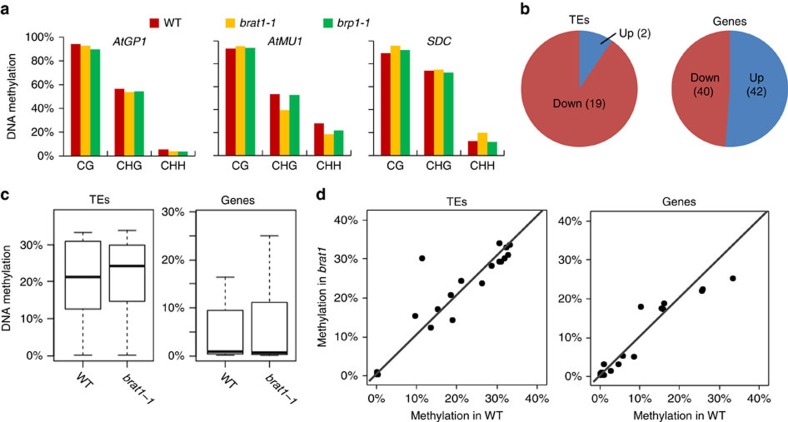
BRAT1 and BRP1 affect the transcript levels of their target loci without alteration of DNA methylation.(a) The DNA methylation levels of AtGP1, AtMU1 and SDC were calculated from the whole-genome bisulfite sequencing data. The percentages of CG, CHG and CHH methylation are separately shown. (b) Numbers of TEs and protein-coding genes up- or downregulated in brat1 relative to the wild type (WT) as determined by the RNA deep sequencing analysis. (c,d) DNA methylation levels of downregulated TEs and genes in brat1 were indicated by box plots and scatter plots.